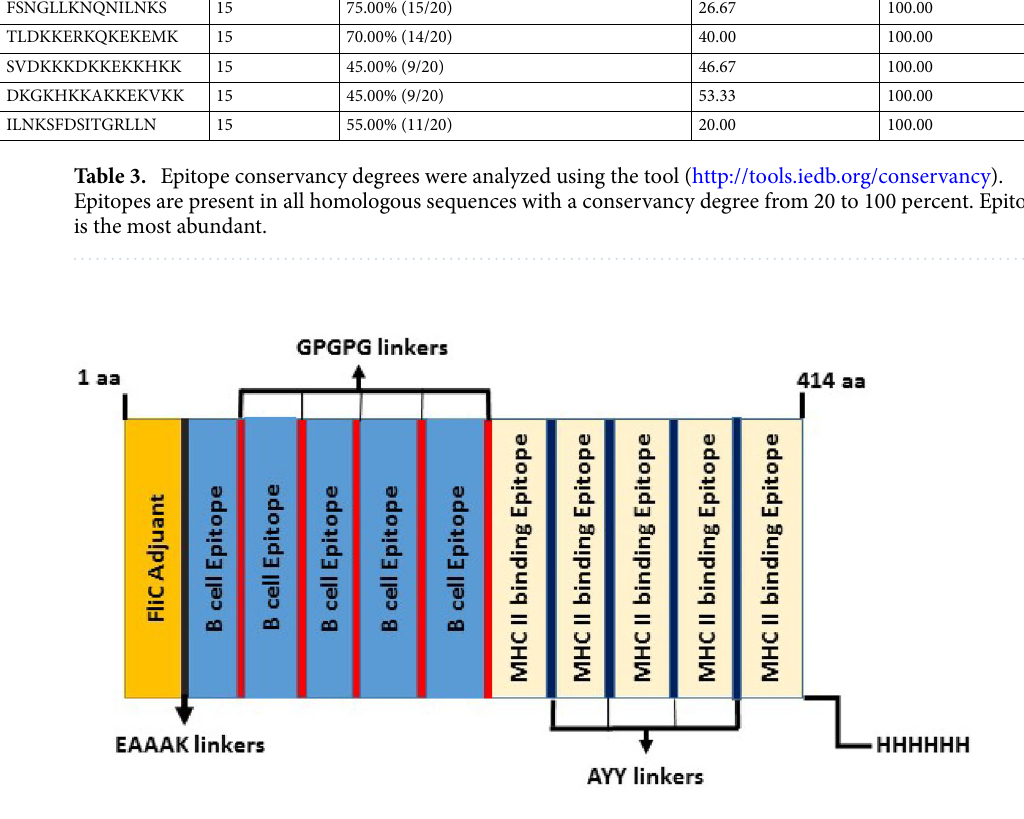
Figure 1. The schematic map of the final vaccine construct. In this construct, the adjuvant sequence was placed at the N-terminal and joined a multi-epitope sequence with the EAAAK linker (Black). GPGPG (Red) and AYY linkers (Blue) were used to bond B and HTL epitopes. The 414-amino acid long multi-epitope sequence was constructed. 6x-His-tag was placed at the C-terminal of the multi-epitope sequence to identify and purification